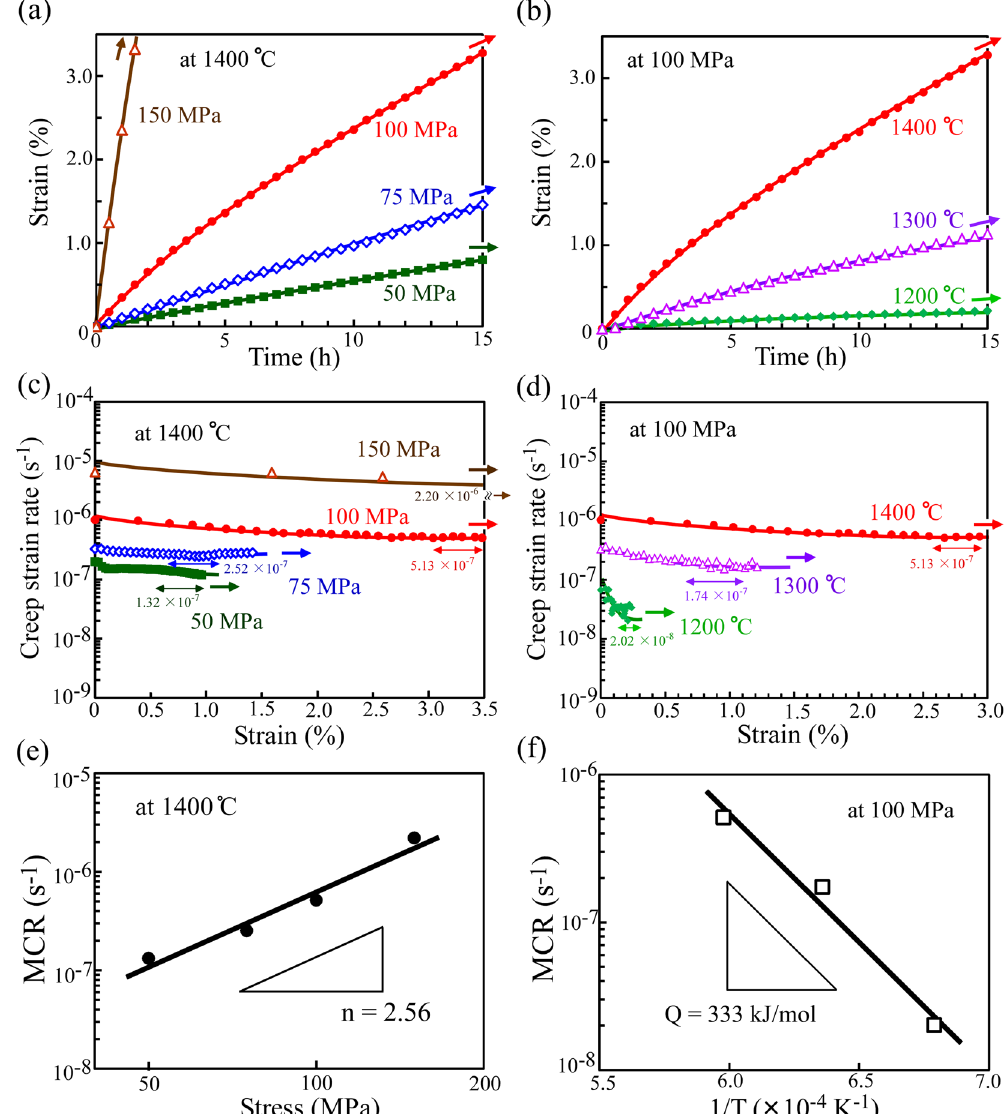
Figure 5. Compressive creep-deformation behavior of the CrIr-added crystals in the 45° orientation. ( a ) Creep strain versus time curves at 1400 °C and 50, 75, 100, and 150 MPa and ( b ) at 100 MPa and 1200, 1300, and 1400 °C. ( c , d ) Corresponding creep strain rate versus strain curves for Figs ( a , b ), respectively. ( e , f ) Variations in the MCR in the 45° orientation ( e ) at 1400 °C as a function of the applied stress and ( f ) at 100 MPa as a function of the reciprocal of the